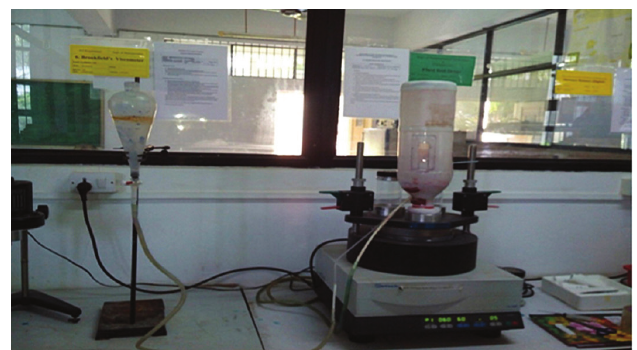
FIGURE 1 - Fabricated fluid bed